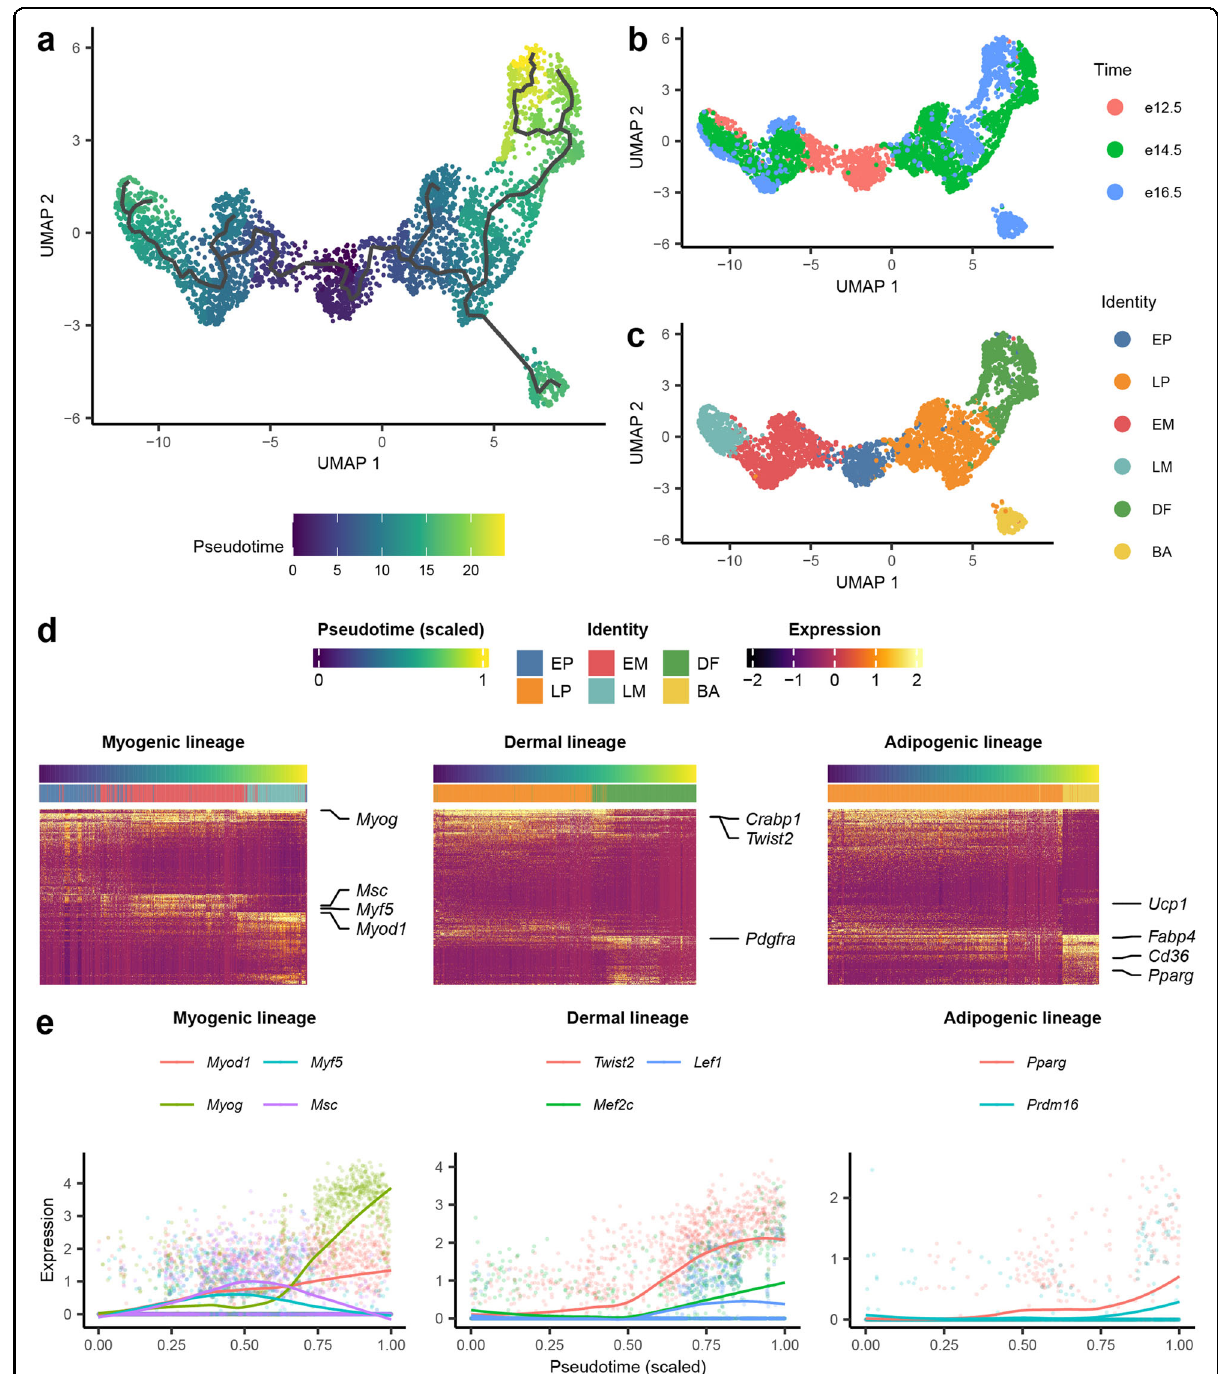
Fig. 2 Pseudotime trajectory and its correlation with gene expression in lineages. a UMAP of YFP + cells (excluding neurons and pericytes) labeled by pseudotime value with trajectory from Monocle 3. b UMAP of YFP + cells (excluding neurons and pericyte) labeled by embryo harvest time. c UMAP of YFP + cells (excluding neurons and pericyte) labeled by identity. d Z-score heatmap of gene expression in different branches, where rows are genes and columns are cells ranked by pseudotime value. Genes were fi rst fi t with generalized additive model (GAM) with ranked pseudotime as independent variable. Genes with the most signi fi cant time-dependent model fi t (lowest P -value) were extracted and clustered by hierarchical clustering. Cells were ordered according to scaled pseudotime value from 0 to 1. Left, Myogenic lineage from EP to EM and LM; Middle, Dermal lineage from LP to BA; Right, Brown adipogenic lineage from LP to DF. e Scatter plot of temporally expressed genes obtained from GAM to scaled pseudotime. LOESS line of expression level was shown for each